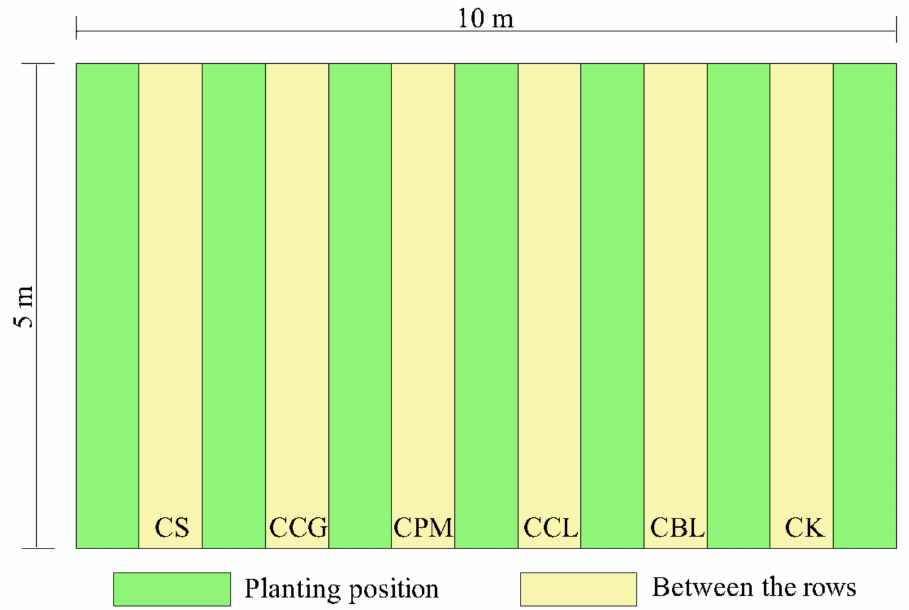
Figure 2. Schematic diagram of the experimental field layout. Note: CS— Camellia sinensis ; CCL— C. sinensis + Cunninghamia lanceolata ; CPM— C. sinensis + Pinus massoniana ; CCG— C. sinensis + Cinnamomum glanduliferum ; CBL— C. sinensis + Betula luminifera ; CK—control. The same notation is used in subsequent